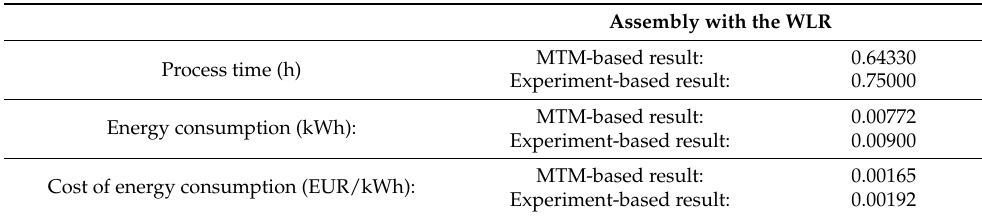
Table 2. The energy consumption of the WLR during the full-wire assembly process (the WLR consumption time and energy for assembly of one control